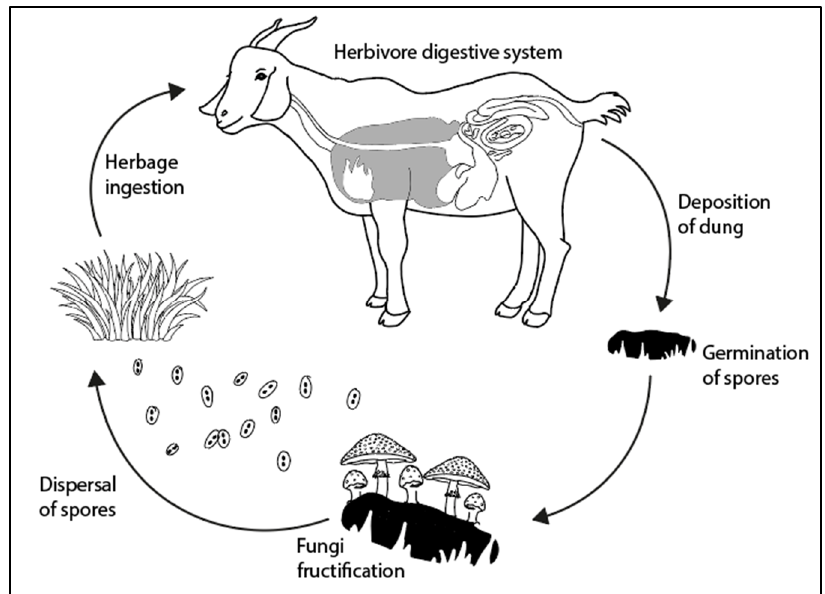
Figure 1. The endocoprophilous life cycle of coprophilous fungi.